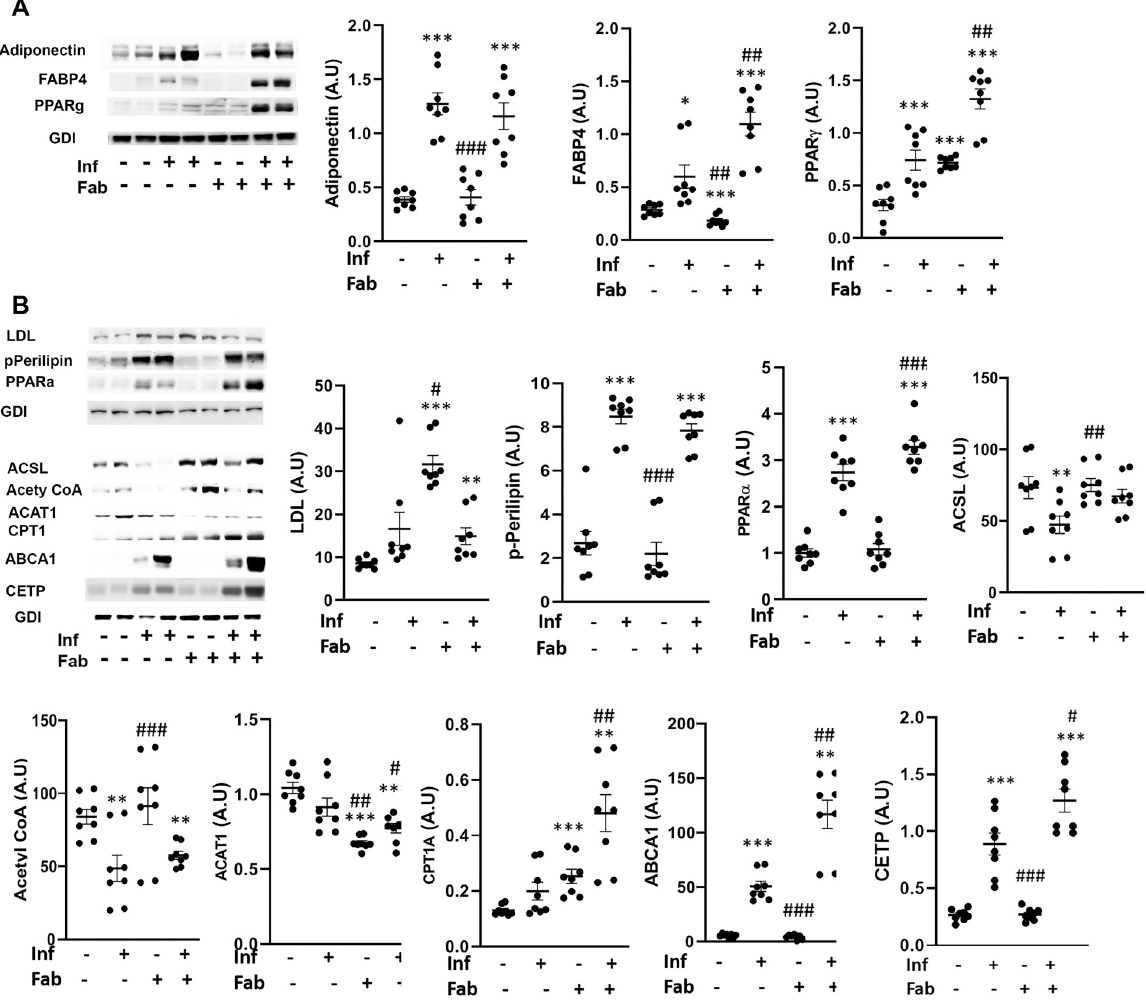
Fig 6. Fat ablation increases adipogenic signaling and elevates lipid levels in the hearts during the early chronic stage in T . cruzi infected mice. Immunoblot analysis of (A) adipogenic markers (FABP4, PPAR γ and adiponectin), and (B) lipid metabolism (LDL and lipid metabolism markers (p-perilipin, PPAR α , acyl-CoA ligase (ACSL) and acetyl Co-A carboxylase, CPT1, ABCA1 and CETP) in the hearts of indicated mice (infected or uninfected mice, fat-ablated (Fab +) or fat-unablated (Fab -) n = 8). The change in protein levels were normalized to the levels of Guanosine nucleotide dissociation inhibitor (GDI) and plotted column scatter graph. The error bars represent SEM. A.U. indicates arbitrary unit. � p � 0.05, �� p � 0.01 or ��� p � 0.001 compared with uninfected fat-unablated. # p � 0.05, ## p � 0.01 or ### p � 0.001 compared with infected fat-